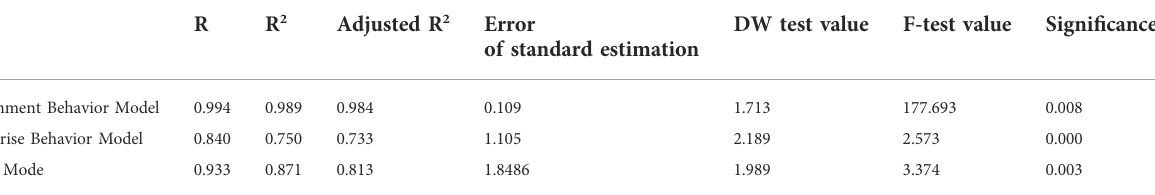
TABLE 3 Summary of behavior pattern model.